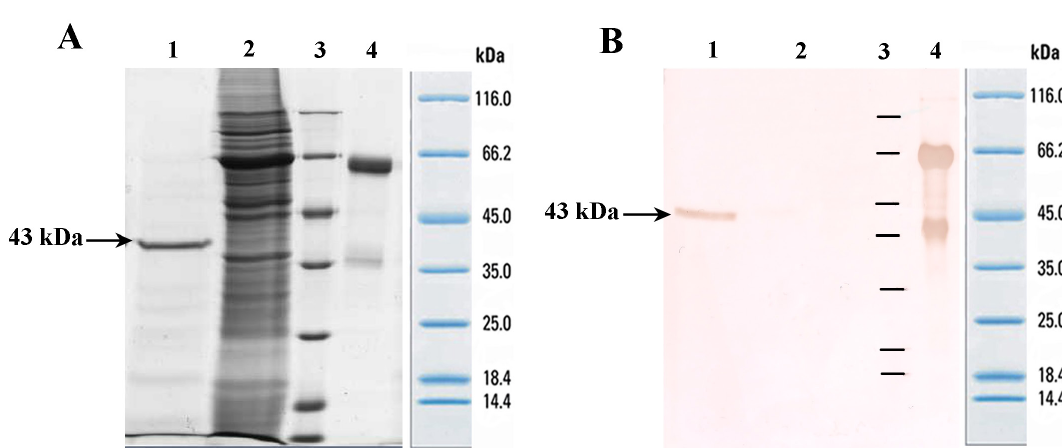
FIGURE 3 - SDS-PAGE and Western blotting analysis of mt-PA after purification. (A) Analysis of mt-PA expression in transfected CHO cells supernatant on a 12% polyacrylamide gel. Lane 1, The mt-PA CHO cell culture medium; Lane 2, Supernatant from non-transfected CHO cell culture medium as negative control; Lane 3, Unstained Protein MW Marker (Thermo Scientific); Lane 4, Alteplase (positive control). (B) Western Blotting analysis of the mt-PA expression in the transfected CHO cells supernatant. Lane 1, The mt-PA CHO cell culture medium; Lane 2, Supernatant from non-transfected CHO cell culture medium as negative control; Lane 3, Unstained Protein MW Marker (Thermo Scientific); Lane 4, Alteplase (full length